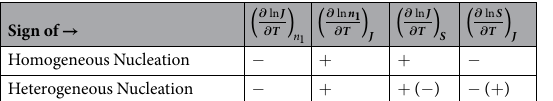
Table 2. Summary of temperature dependencies for homogeneous and heterogeneous vapor to liquid nucleation. For homogeneous nucleation J = J hom . For heterogeneous nucleation J is equal to the per particle nucleation rate, J 1 . Signs for the unusual temperature dependences are indicated by parenthesis.